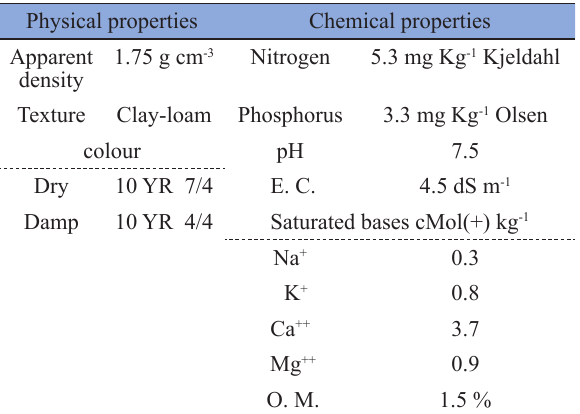
Table 1. Physical and chemical properties of an endoleptic lithosol soil. Universidad Tecnológica de Tehuacán. Summer of